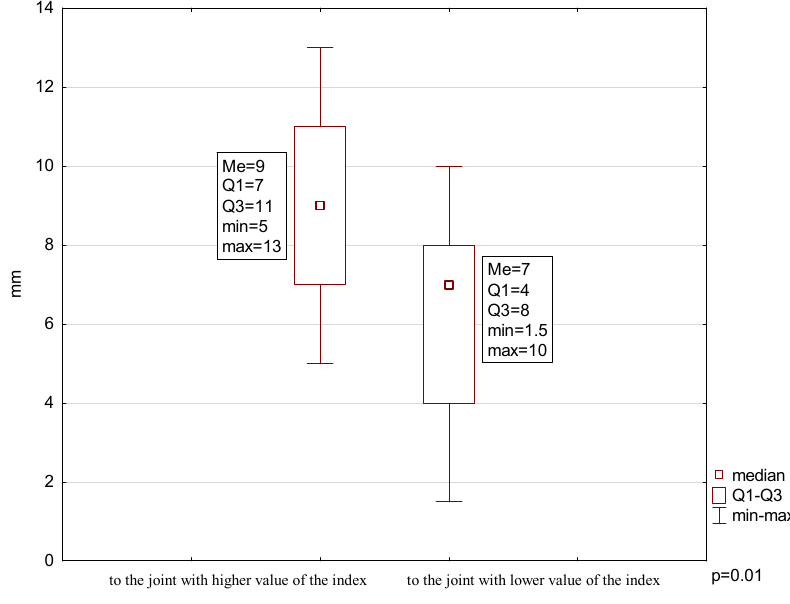
Figure 3. Range of mandibular lateral movements.